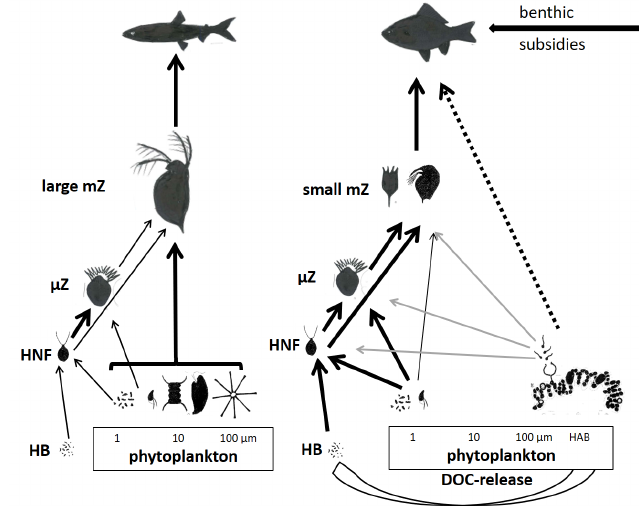
Figure 3. Major trophic pathways to plankton-feeding fish under two scenarios of the pelagic food web, left: oligotrophic scenario with Daphnia as main mesozooplankton and coregonids as main planktivore fish, right: eutrophic scenario with Cyanobacteria as main phytoplankton and cyprinid fish as main planktivores. Thick arrows: feeding pathways more important than in the other scenario; thin arrows: feeding pathways less important than in the other scenario; dotted arrow: feeding pathway only realized with fish feeding on Cyanobacteria; grey arrows: matter and energy transfer via release of zoospores by fungal parasites; open, bent arrow: matter and energy transfer via DOC (dissolved organic carbon)-release by senescent Cyanobacteria. Abbreviations: HB: heterotrophic bacteria; HAB: harmful algal blooms; HNF: heterotrophic nanoflagellates; µZ: microzooplankton; mZ: mesozooplankton. If small- and medium-sized phytoplankton dominate the primary producer trophic level a big portion of primary production is directly consumed by mesozooplankton, in many lakes by Daphnia . This pathway of carbon and energy flow is further strengthened by feeding of mesozooplankton on heterotrophic protists and subsequent reduction in their competitors, a kind of “eating your competitor strategy” [116]. Plankton-feeding fish then feed on mesozooplankton, leading to a short food chain with mesozooplankton at trophic level 2 to 3 and planktivorous fish close to trophic level 3 to 4. If fish feeding on cyanobacteria are lacking, most of the cyanobacterial biomass is not consumed directly by zooplankton but decays at the end of blooms, the decay being possibly enhanced by viral lysis. The subsequent release of DOC stimulates bacterial growth and bacterial production becomes a major carbon and energy source of higher trophic levels [117]. The bacteria are preyed upon by heterotrophic nanoflagellates and microzooplankton, which then serve as food for mesozooplankton. There might also be some transfer of cyanobacterial production to mesozooplankton by chytrid parasitism on Cyanobacteria, release of zoospores and zooplankton feeding on zoospores [118,119]. Due to the detrital and the parasitic loop, mesozooplankton are at trophic level 3 to 4. This food chain elongation is predicted to lead to increased losses of carbon on